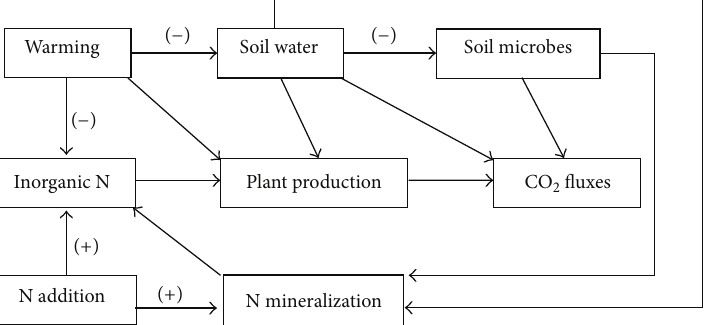
Figure 8: Conceptual diagram of experimental warming and N enrichment on ecosystem C and N cycling in semiarid alpine meadow. “+” refers to positive stimulation effect and “ − ” refers to inhibiting